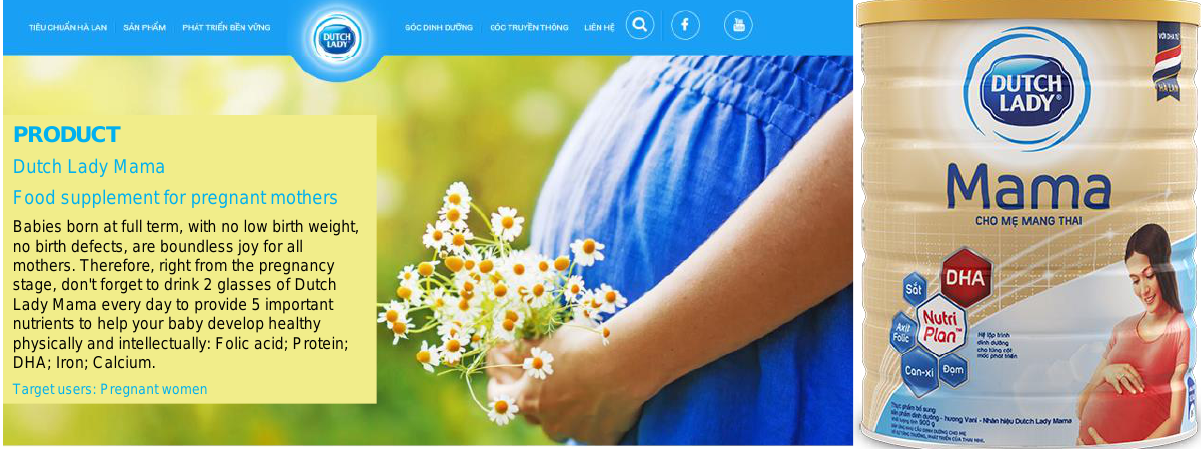
Figure 3. Dutch Lady Mama’s benefit icons convey several health claims for babies [20].